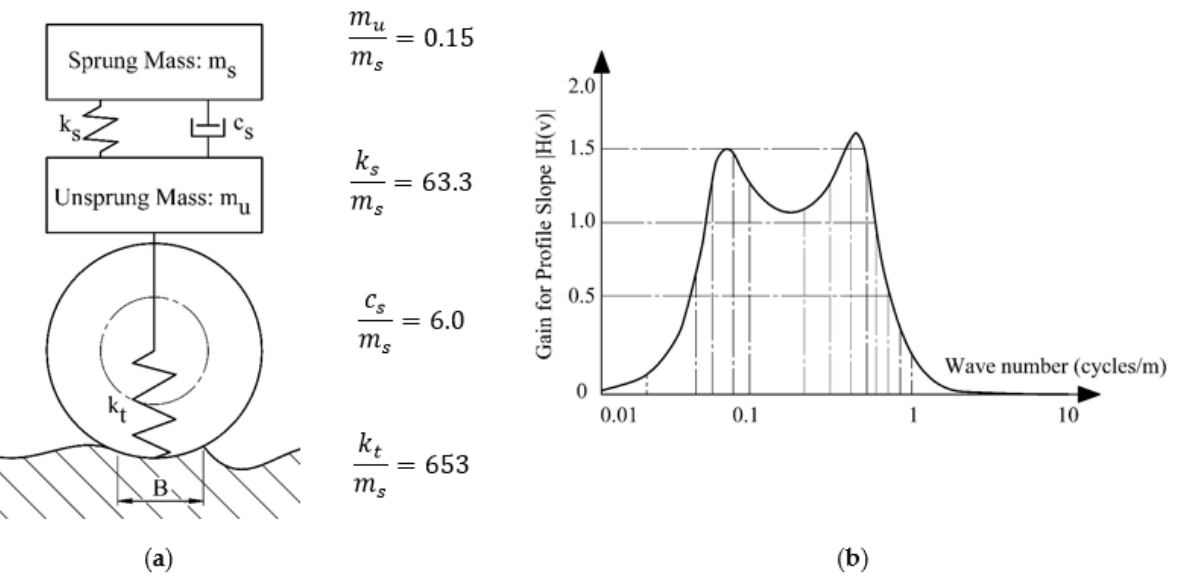
Figure 1. IRI computation and evaluation [39]: ( a ) Golden car model and its parameters; ( b ) IRI sensitivity to wave number.